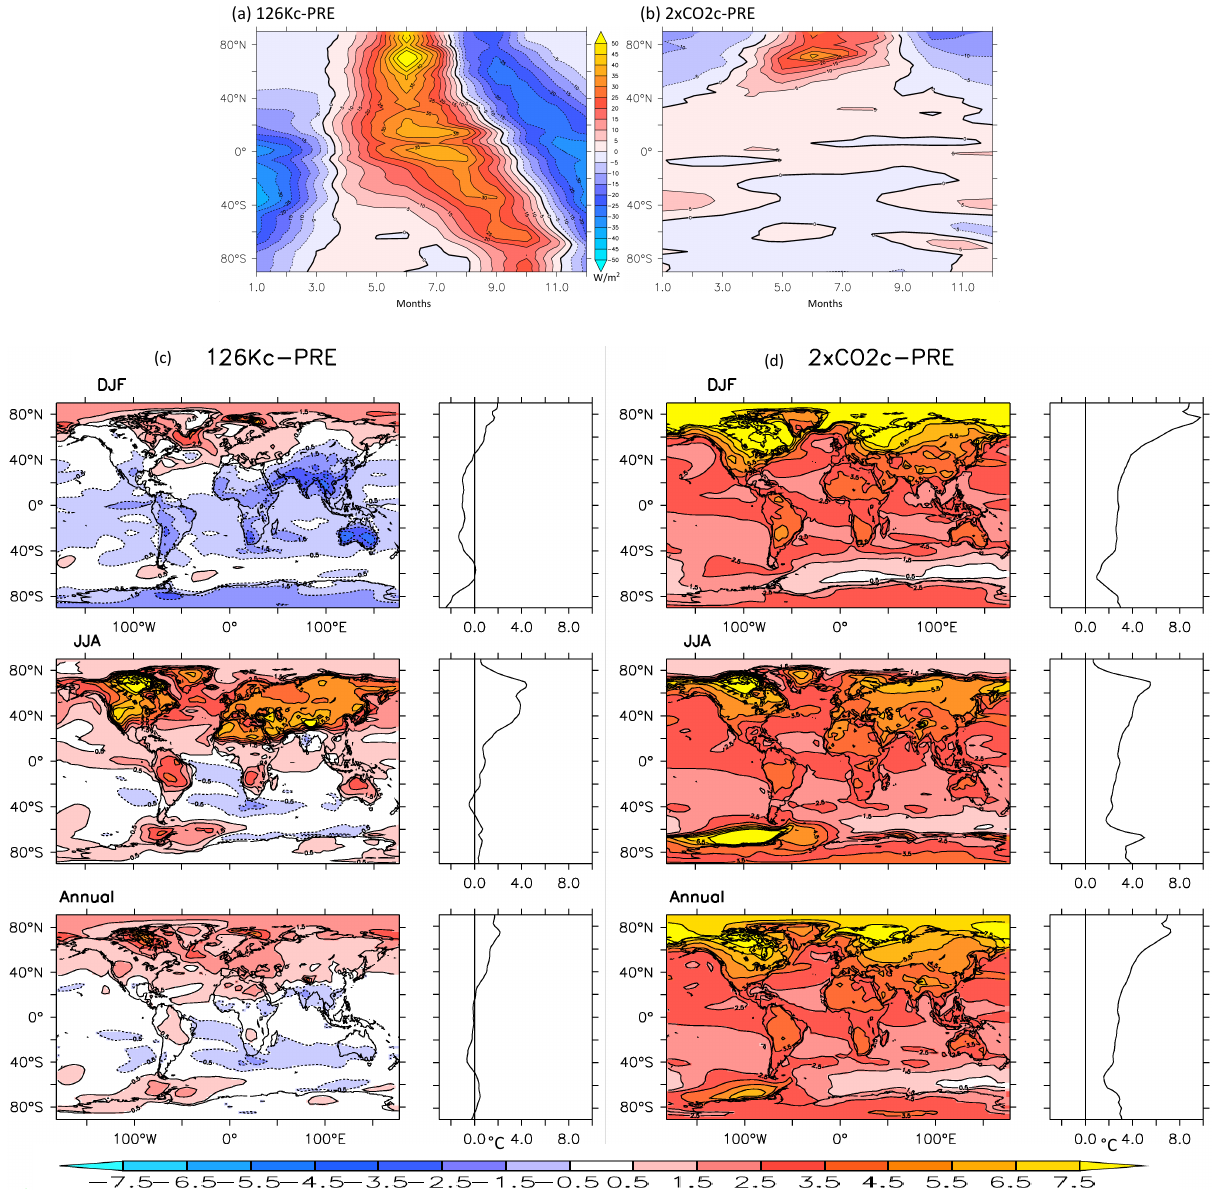
Fig. 3. Comparison of anomalies between the last interglacial and pre-industrial control IPSL model simulations (left panel) and 2 × CO 2 and pre-industrial control simulation (right panel) for : (a) and (b) TOA net radiative budget (Wm − 2 ); (c) and (d) surface air temperature ( ◦ C) and (e) and (f) evaporation (mmday − 1 ). For panels (a) and (b) , anomalies are displayed as a function of month number (horizontal axis) and latitude (vertical axis). For panels (c) to (f) , anomalies are displayed as a function of longitude and latitude, for DJF (December- January-February), JJA (June-July-August) and for the annual mean. On the right side of each panel (c) to (f) , zonal mean anomalies are also displayed as a function of